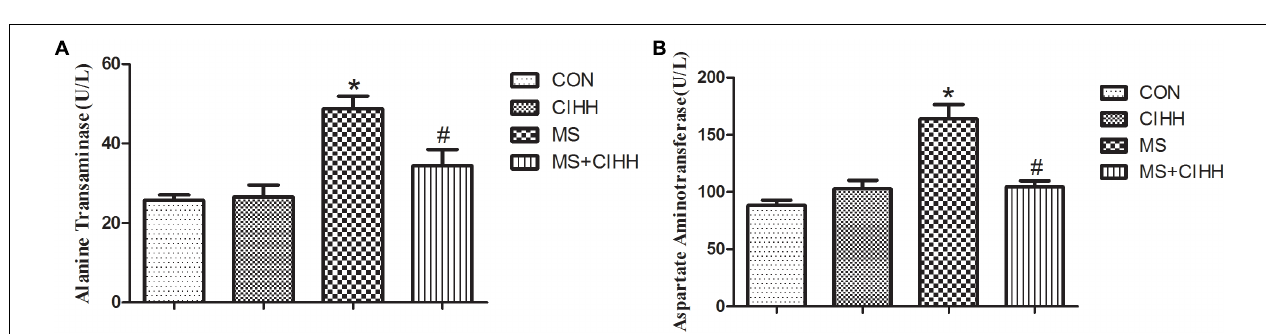
FIGURE 4 | Effect of CIHH on the level of alanine transaminase (A) and aspartate aminotransferase (B) . CON: control group, CIHH: CIHH group, MS: metabolic syndrome group, MS + CIHH: MS + CIHH group. All data were expressed as mean ± SD; n = 6 for each group. * P < 0.05 vs. CON, # P < 0.05 vs. MS.